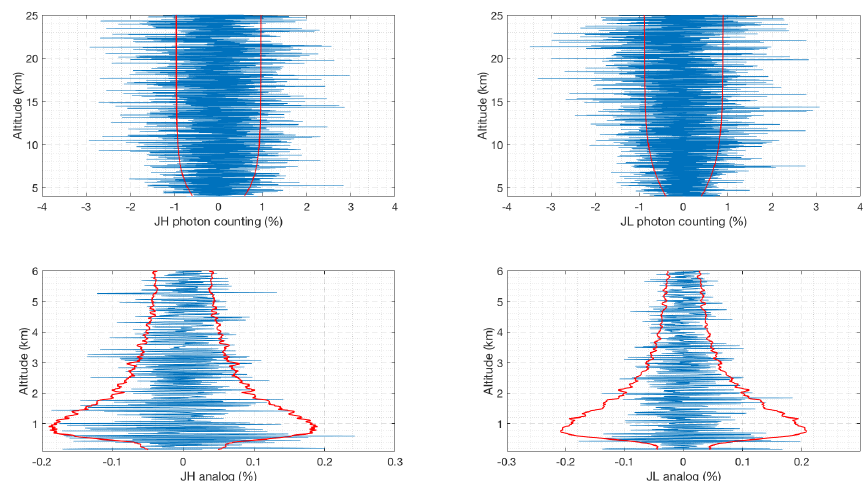
Figure 8. Difference between the forward model and the clear daytime RALMO measurements on 10 September 2011 for the four signals (blue). The red curves show the standard deviation of the measurements.